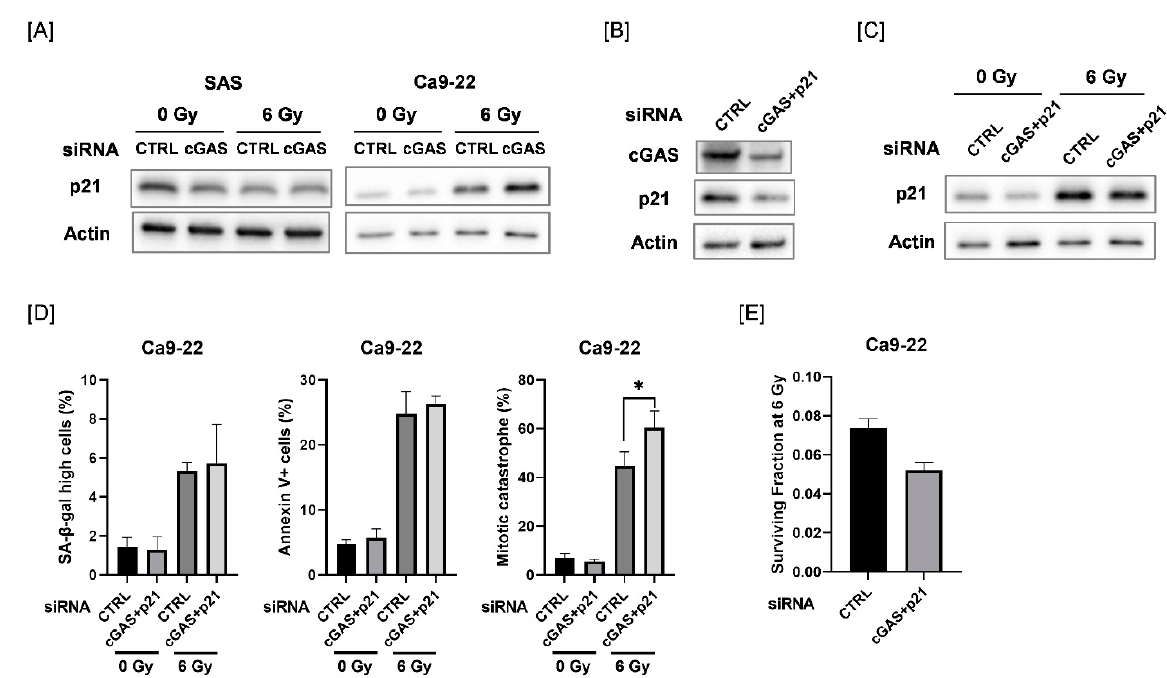
Figure 5. Involvement of p21 in the cGAS-mediated radiation response of Ca9-22 cells. ( A ) HNSCC cells (SAS and Ca9-22) transfected with the control or cGAS siRNA were harvested and irradiated with 6 Gy X-rays. After four days of culture, the cells were harvested for western blot analysis. A representative immunoblot image is shown. Actin was used as the loading control. ( B ) Ca9-22 cells transfected with control or cGAS and p21 siRNA were harvested. After 24 h of culture, the cells were harvested for western blot analysis. A representative immunoblot image is shown. Actin was used as the loading control. ( C , D ) Ca9-22 cells transfected with the control or cGAS and p21 siRNA were irradiated with 6 Gy X-rays and cultured for four days. The cells were harvested for western blotting ( C ) and analysis for SA- β -gal activity, apoptosis, and mitotic catastrophe ( D ). ( C ) A representative immunoblot image is shown. Actin was used as the loading control. ( D ) The percentages of SA- β -gal high-activity, annexin V + apoptotic cells, and mitotic catastrophe are shown. * indicates p < 0.05. ( E ) Ca9-22 cells transfected with control or cGAS and p21 siRNA were irradiated with 6 Gy X-rays. After about 24 h of culture, the cells were harvested and seeded for colony formation assays. The results are shown as the surviving fraction at 6 Gy. The representative result is shown. Similar results were obtained in two different experiments. The data are mean ± SD of triplicate.